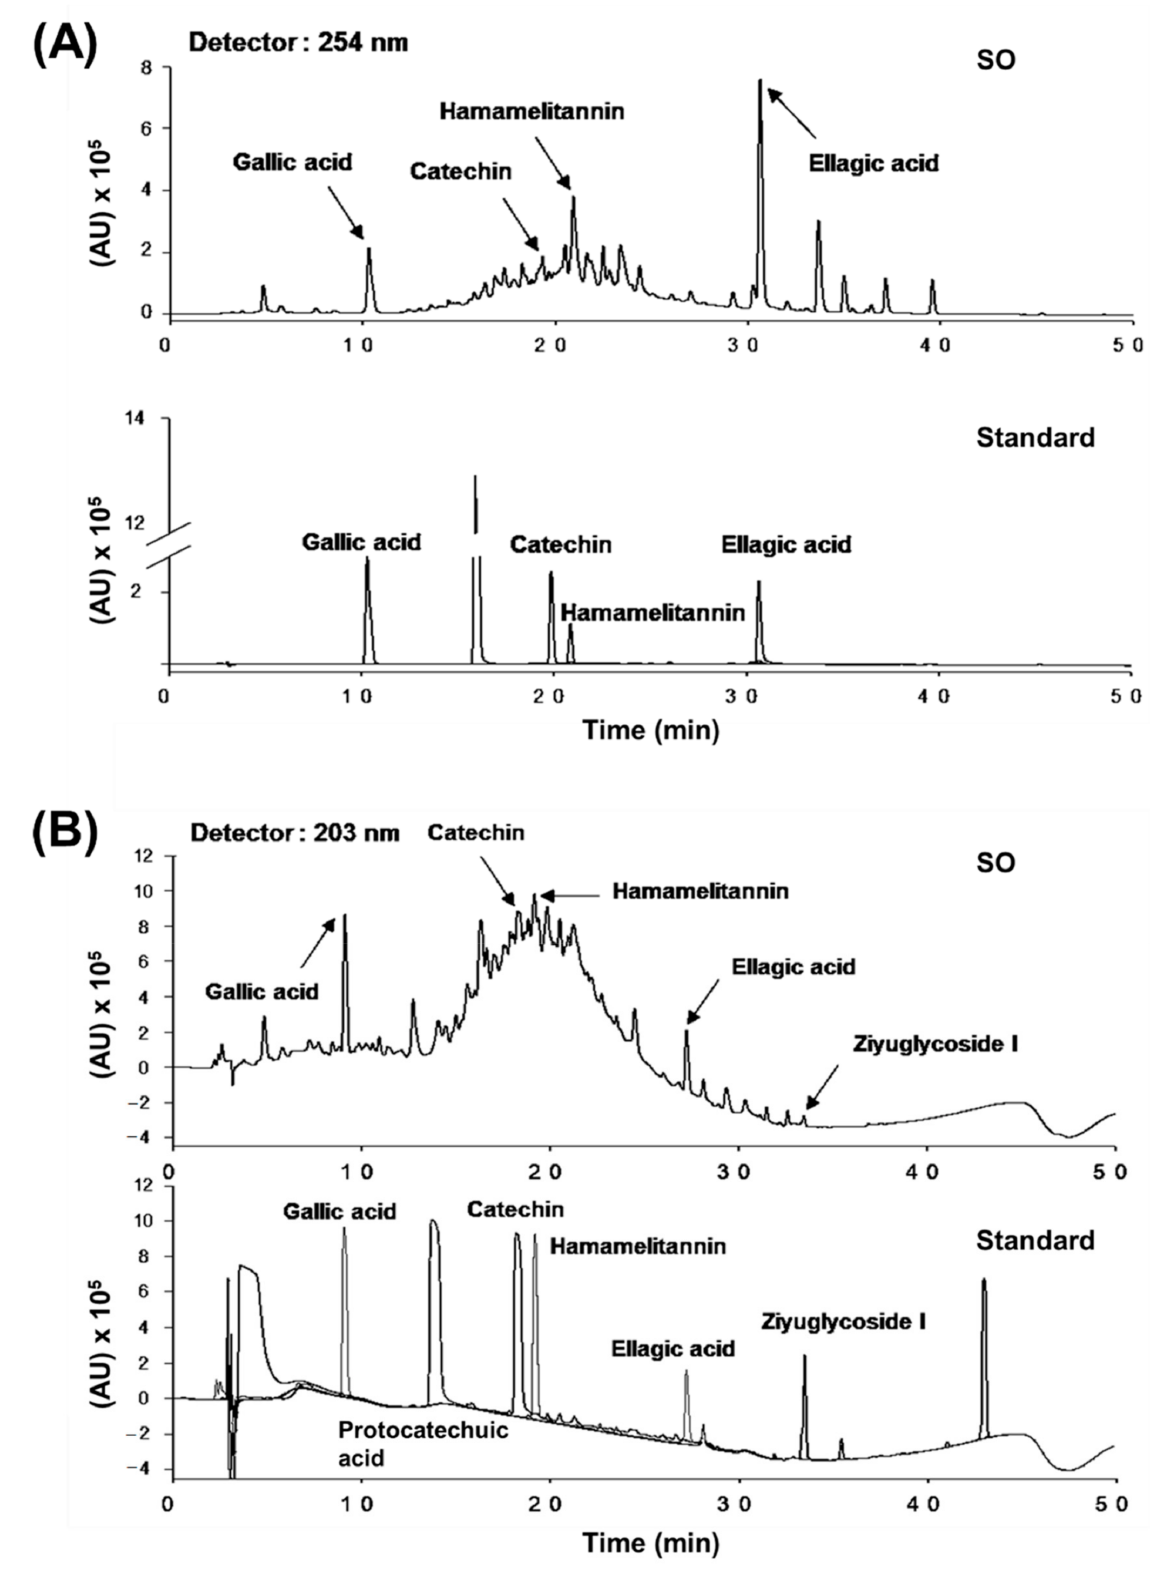
Figure 1. High-performance liquid chromatography (HPLC) analysis of S. officinalis (SO) extract. ( A , B ) The HPLC chromatogram of S. officinalis extract was monitored at ultraviolet detectors of 254 ( A ) and 203 nm ( B ). Representative compounds of S. officinalis extract were indicated by arrow